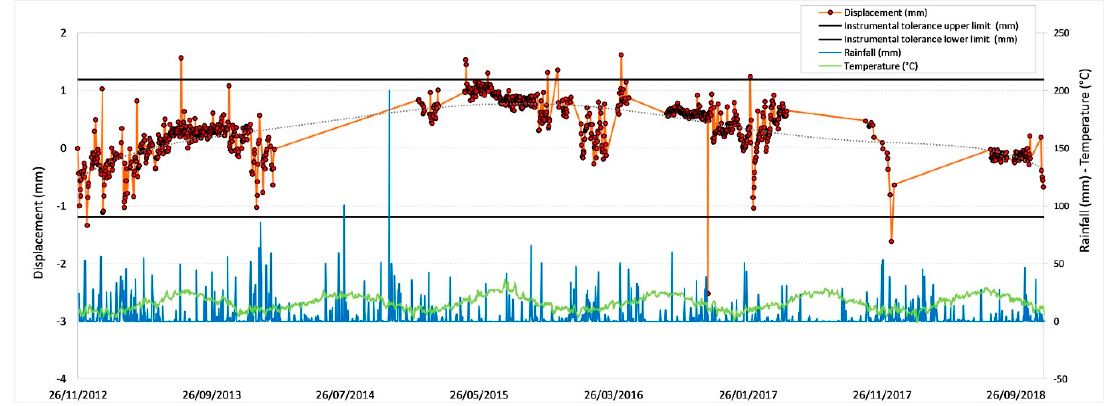
Figure 14. Displacement recorded by the RTS at the measurement point P07.